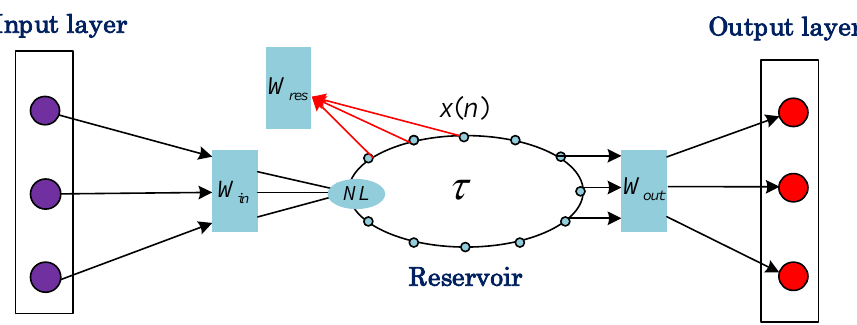
Figure 1. Schematic diagram of RC. W in is the input connection weight matrix, W res is the internal connection weight matrix, W out is the output connection weight matrix, τ is the delay time, x ( n ) is the state function, and NL is the nonlinear node.